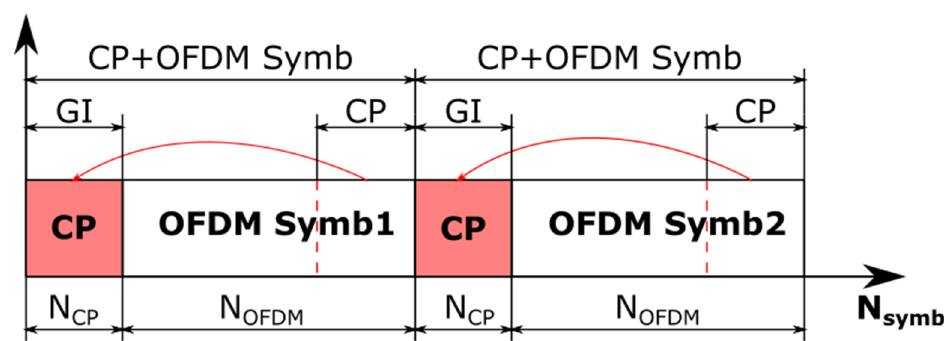
Figure 6. Guard interval (cyclic prefix) insertion.